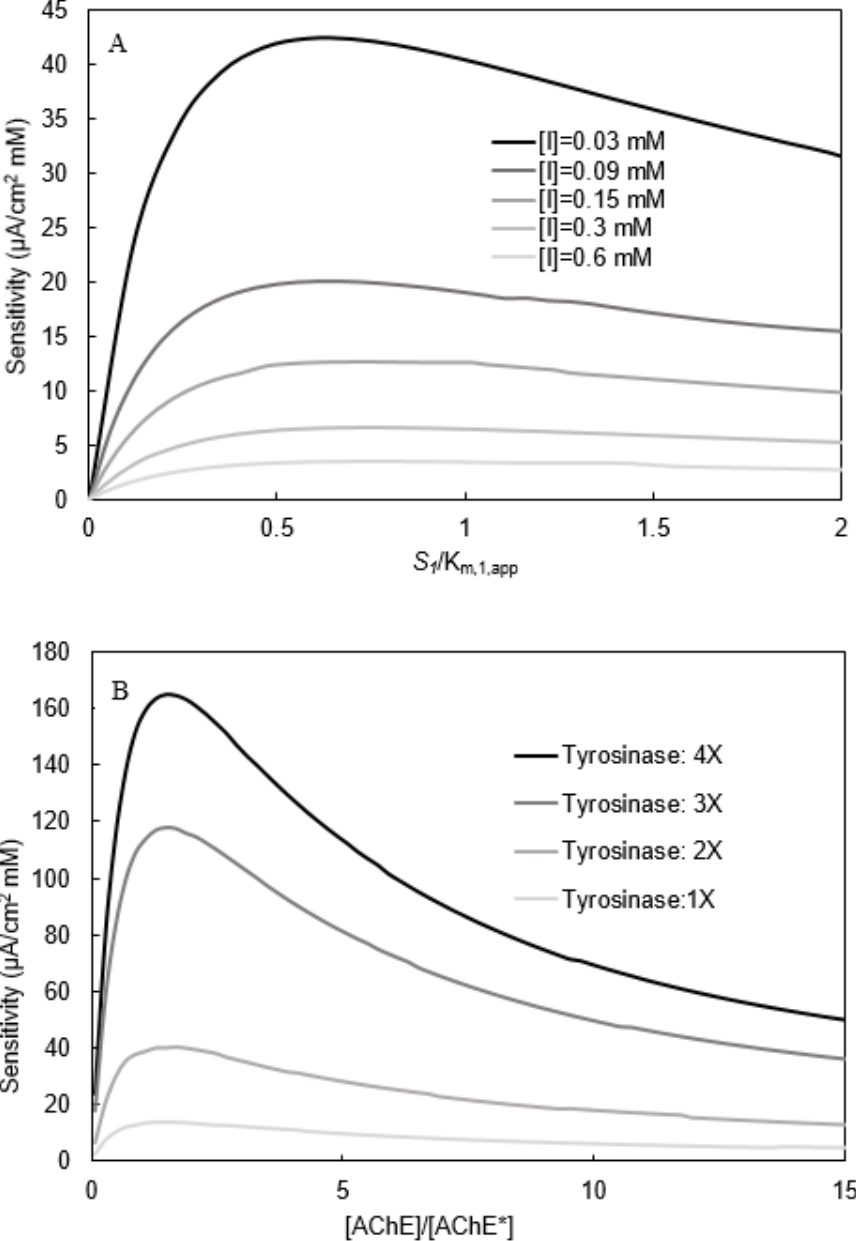
Figure 11. ( A ): Sensitivity vs. phenylacetate concentration (S 1 ). S 1 has been normalized with K m,1,app . ( B ): Sensitivity vs. [AChE] at different tyrosinase concentrations. [AChE] has been normalized with [AChE*] =3 µM. [I] = 0.3 mM.